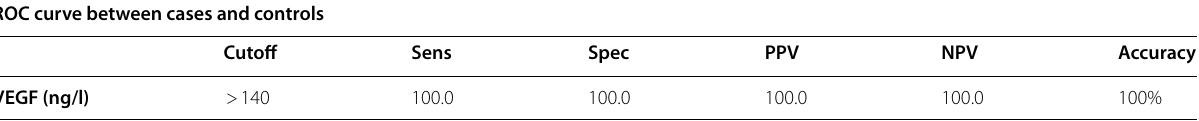
Table 6 ROC curve between cases and controls, showing sensitivity, specificity, and cut-off point of